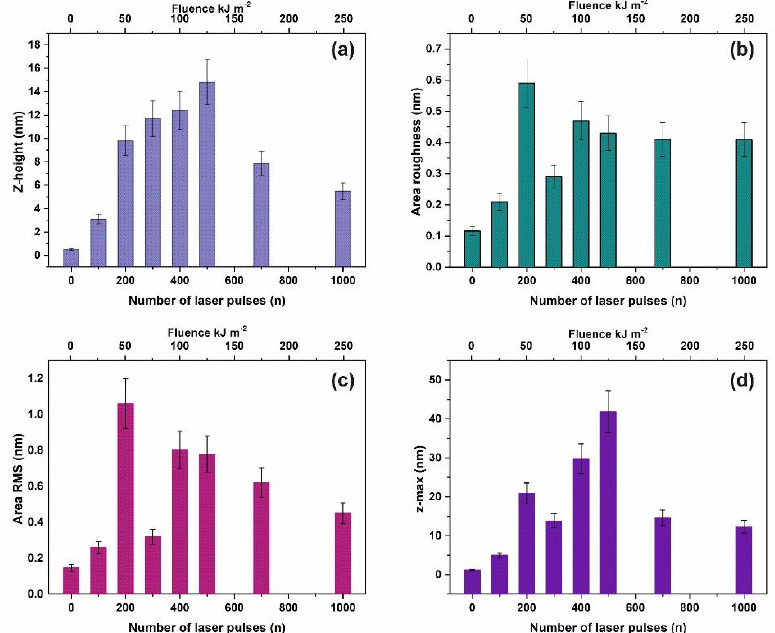
Figure 1. Surface parameters of irradiated polyacrylamide (PAM) layers for a 2 µ m × 2 µ m area: ( a ) Mean z- height; ( b ) area roughness (R a ); ( c ) area RMS; ( d ) maximum range. The area roughness and area RMS parameters show an increment with laser pulses up to ~ 200 lp followed by a dip at 10 3 lp.